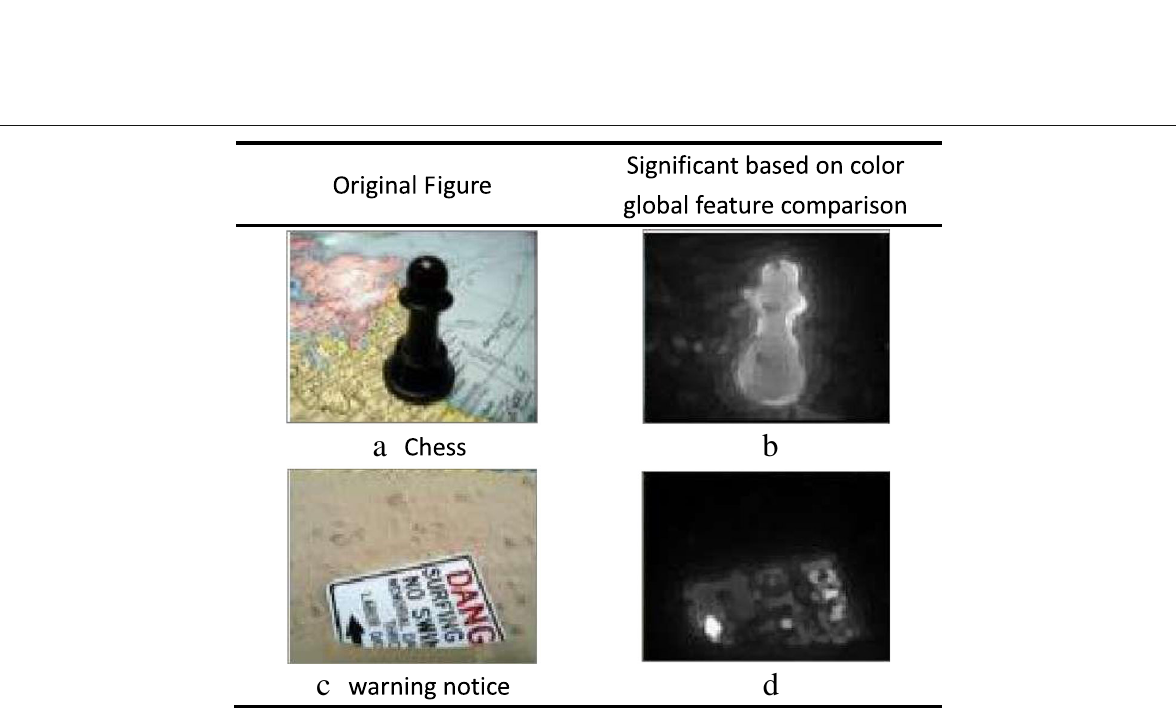
a db c Fig. 8 Examples of saliency diagrams using color global feature comparisons. a Original figure of chess. b The result of chess image using color global feature comparisons. c Original figure of warning notice. d The result of warning notice image using color global feature